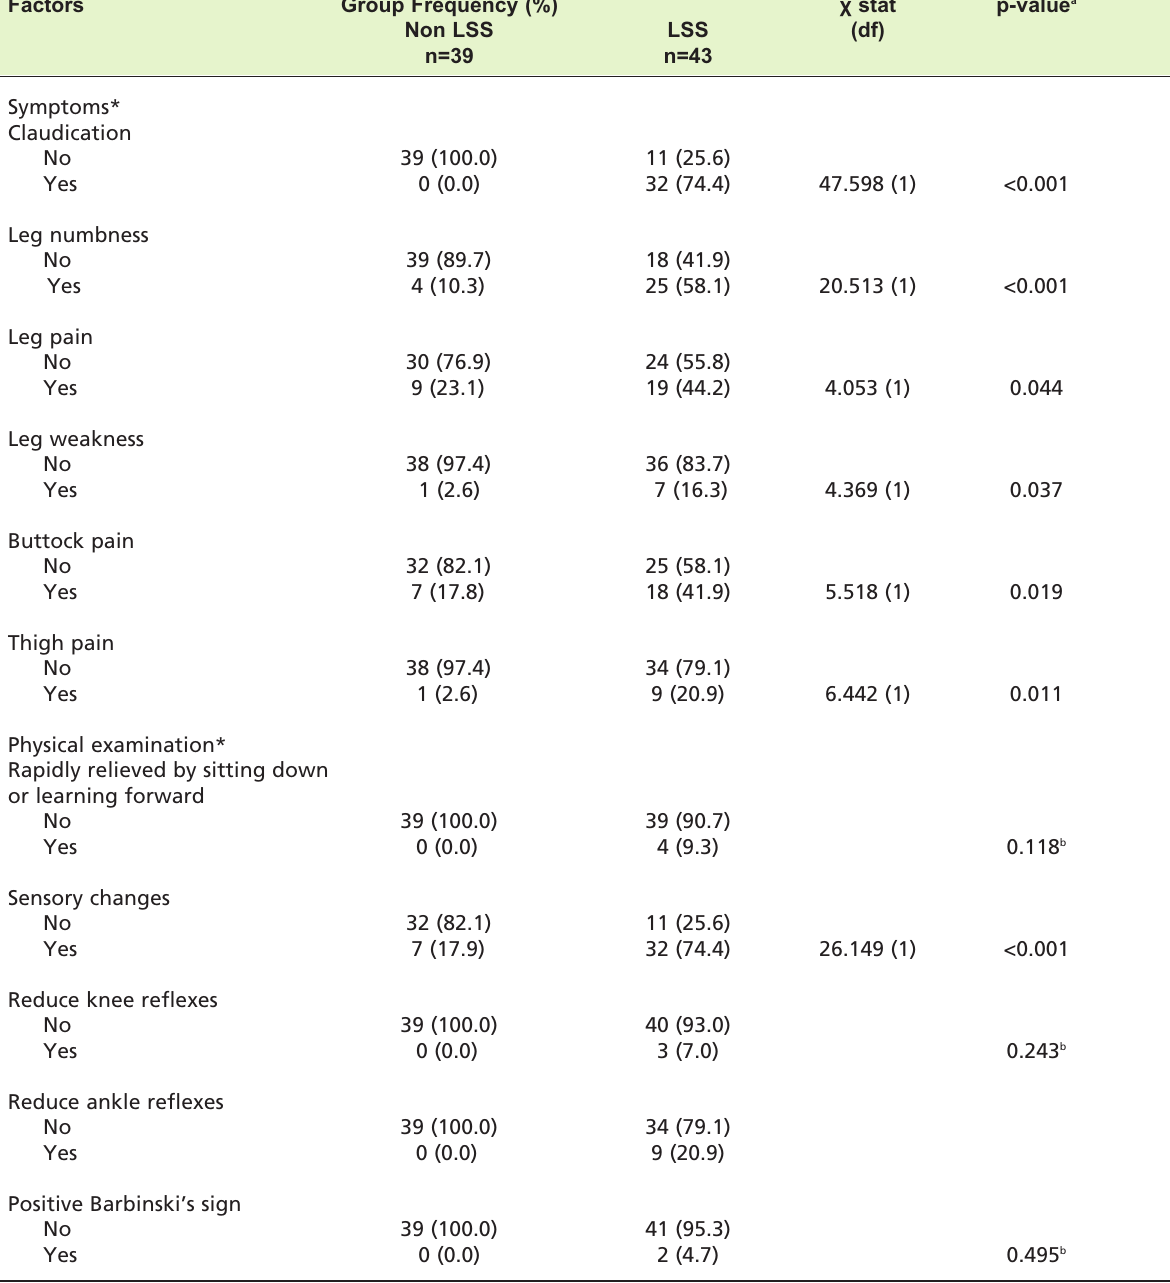
Clinical presentation of patients in Control and LSS Group Table II: